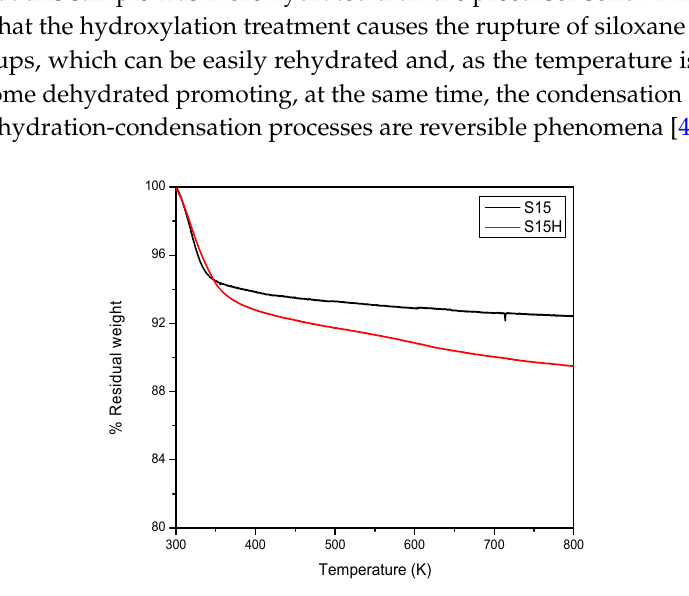
Figure 4. Thermogravimetric analysis under a N 2 atmosphere of the S15 parent sample and of the S15H solid proceeding from the corresponding alkaline hydroxylation of the previous substrate.